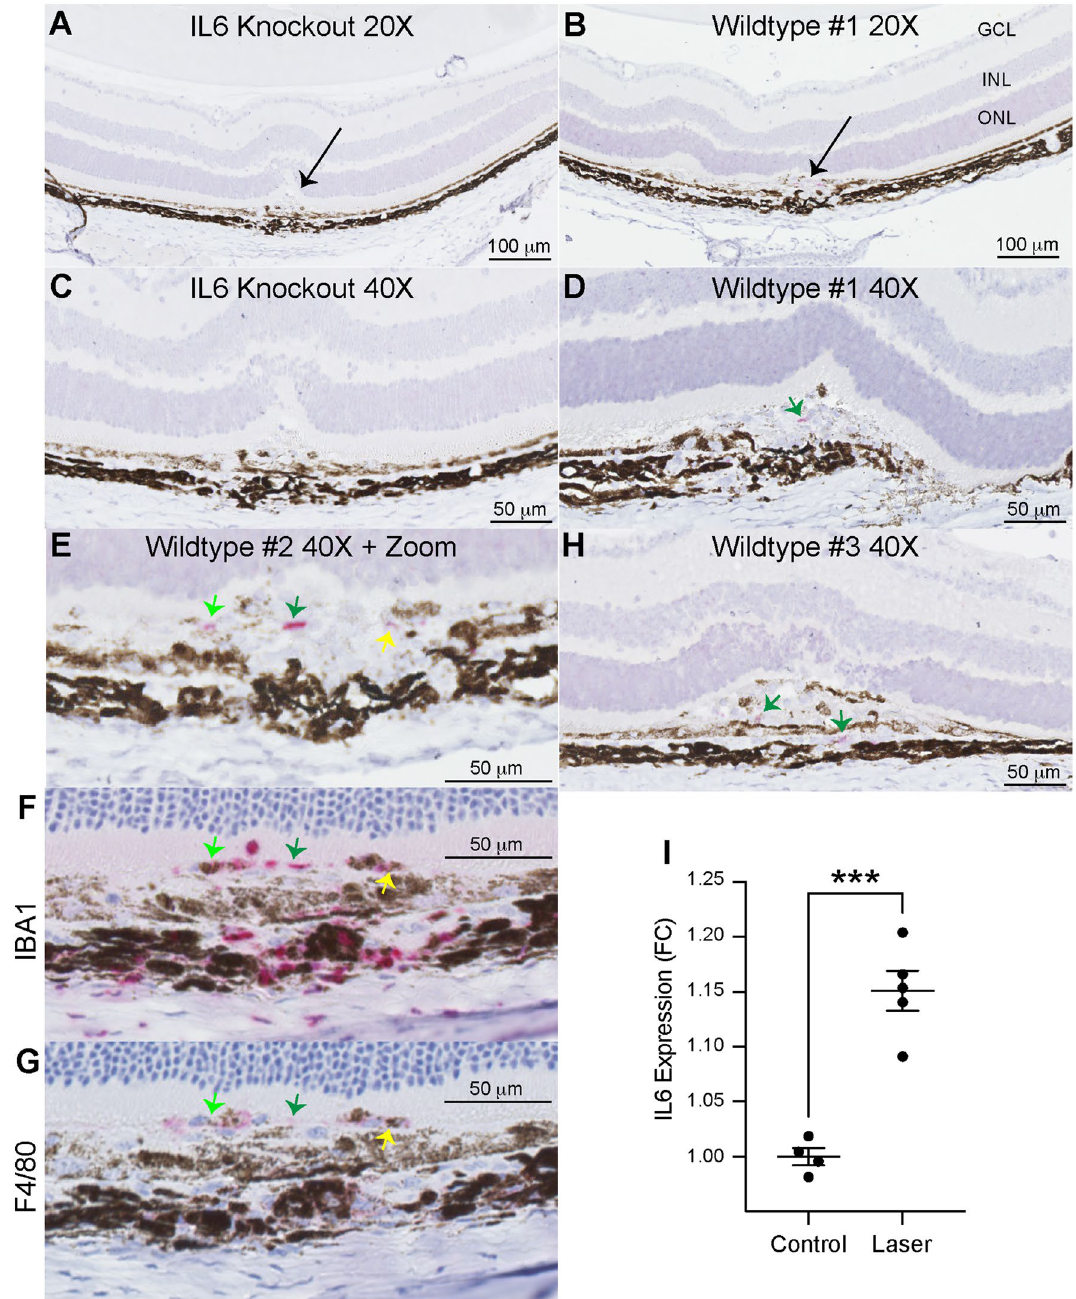
Figure 1. IL6 expression is increased by laser and expressed at the laser injury site. 20X magnification of paraffin-embedded sections stained for hematoxylin and IL6 (pink, RNAscope) from Il6 −/− ( A ) and wildtype ( B ) mice. Arrows indicate laser lesion. 40X magnification of sections stained for hematoxylin and IL6 (pink, RNAscope) from Il6 −/− ( C ) and wildtype ( D , H ) mice. Green arrows indicate IL6 + cells. 40 × magnification with digital zoom of IL6 ( E ), IBA1 ( F ), and F4/80 ( G ) in serial sections from a single lesion. Light green, dark green, and yellow arrows indicate IL6 + cells co-staining for IBA1 and F4/80 in serial sections. ELISA measurements ( I ) of IL6 expression demonstrate a 1.15-fold (*** = p < 0.001, N = 4–5 per group) increase after laser